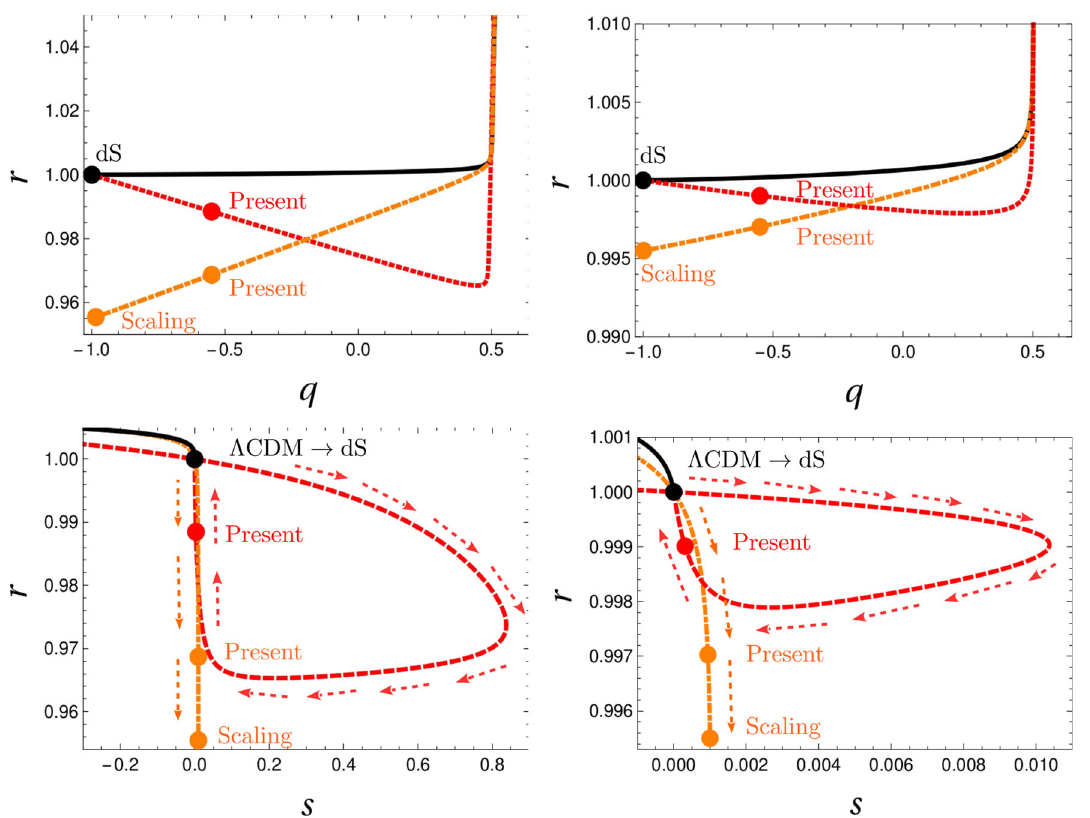
the color code is as follow: (i) solid black line correspond to (cid:2) CDM, (ii) dashed red line correspond to first model and finally, (iii) dot-dashed orange line correspond to second